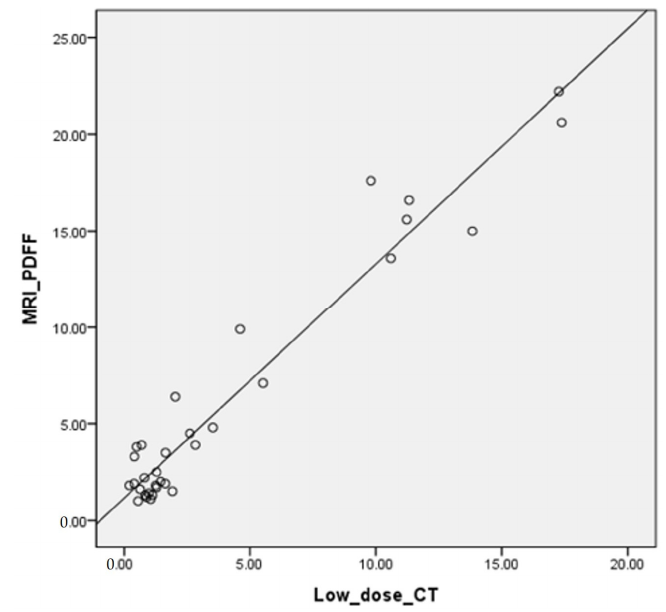
Figure 2. Correlation of FVF with MRI-PDFF.